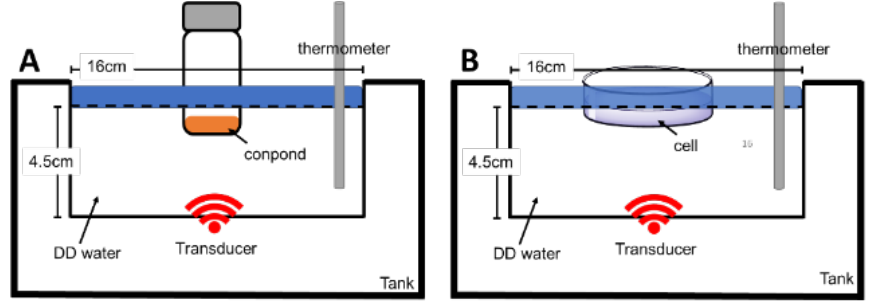
Figure 2. Schematic diagram of ultrasonic instruments used for different purposes in this experiment. ( A ) ROS experiment; ( B ) Cell experiment.